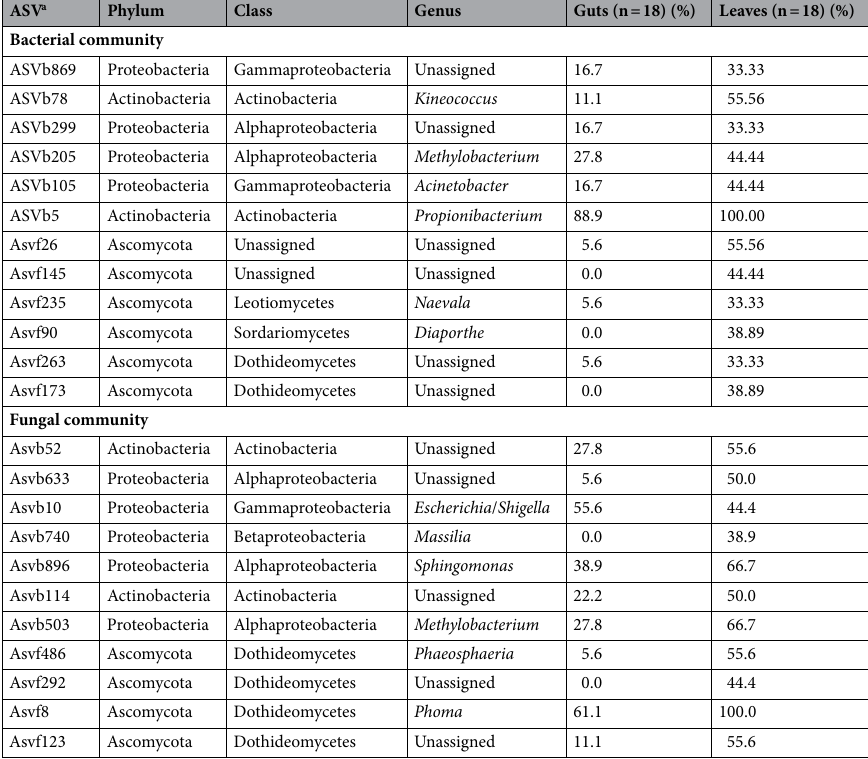
Table 2. Details on the selected ASVs of the variance of bacterial et fungal communities associated to adult EAB guts. In both cases, the values correspond to the percentage of presence of the ASV taxa in all the samples. Only the ASV found to be indicators of a host are shown. a Asvb ASV assigned to bacteria, Asvf ASV related to